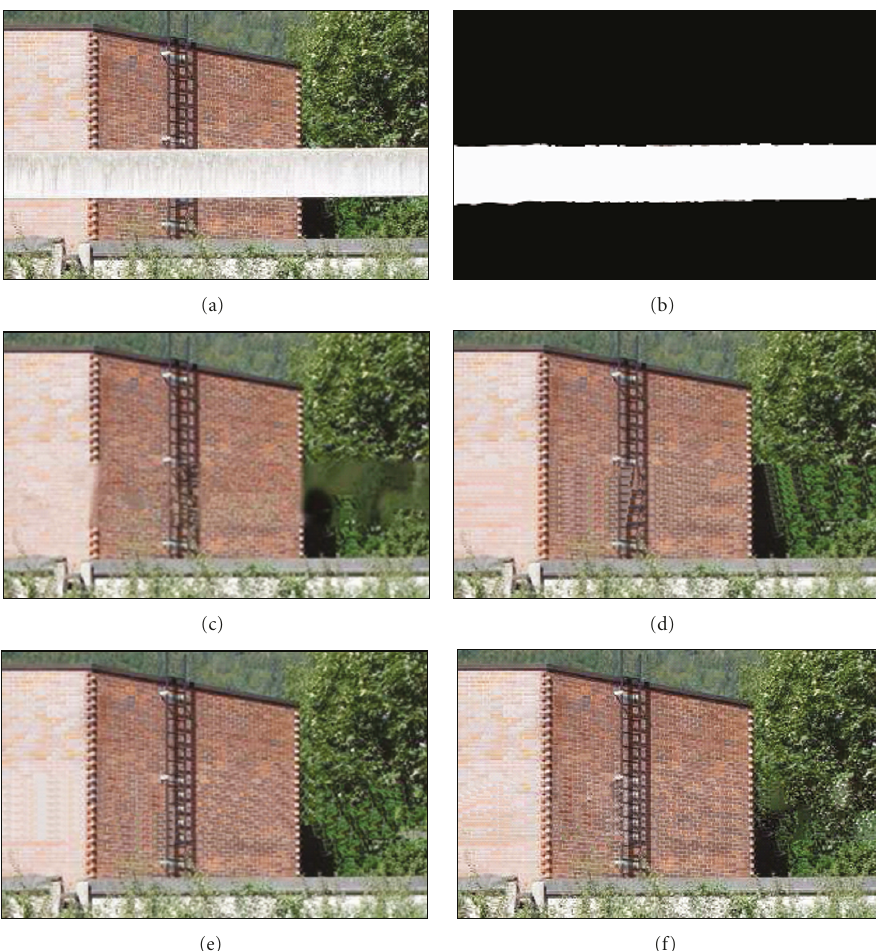
Figure 10: An input image for object removal (a), the mask image (b), the method in [7] (c), the exemplar-based inpainting method [4] (d), the modified exemplar-based inpainting method (e), and the proposed method